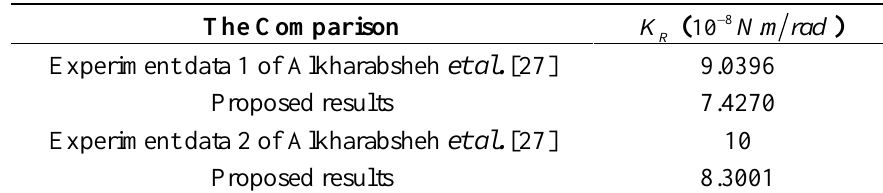
Table 1. The comparison of the equivalent stiffness between the proposed results and the reported experimental data [27].